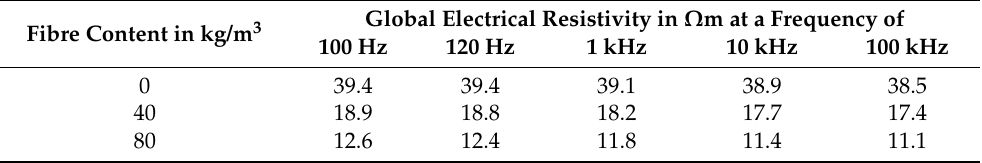
Table A41. Results of the resistivity measurements of the concrete mixture 32-60-300-00 after storage in Ca(OH) 2 for 7 days for the investigations of possible leaching effects.